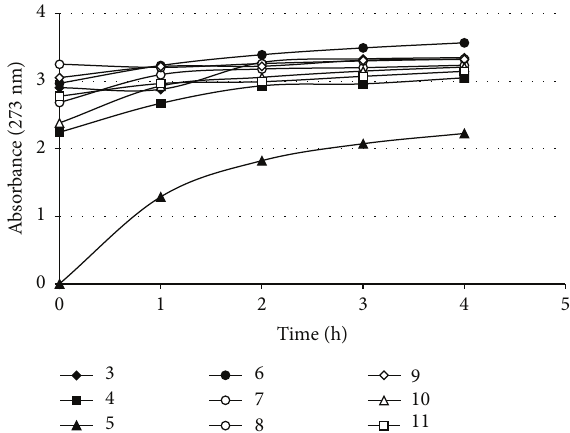
Figure 3: The effect of pH on the synthesis of silver nanoparti- cles using peroxidase enzyme from Euphorbia ( Euphorbia amyg- daloides ).